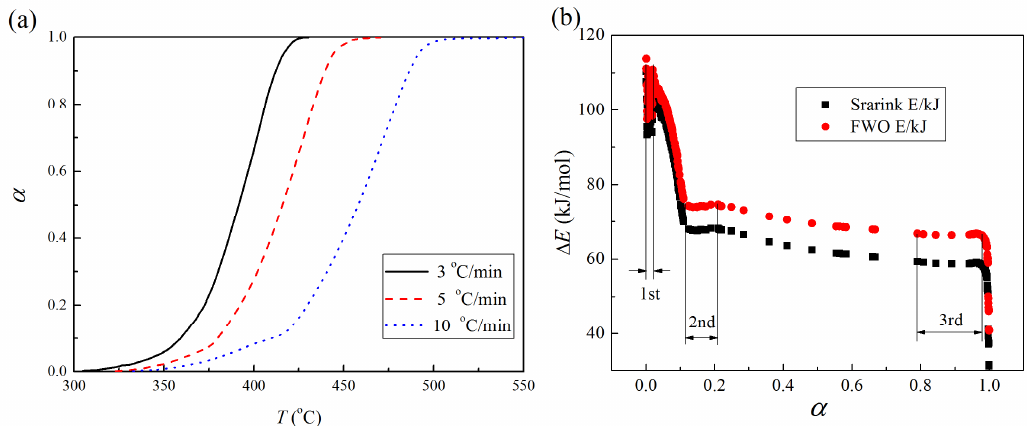
Figure 6. ( a ) Reaction fraction curves and ( b ) Activation energy of the reduction process of hematite particles without heat treatment in pure hydrogen. Table 1. Apparent activation energy of the three stages in the reduction process of hematite in hydrogen. E a (kJ/mol) 1st Stage 2nd Stage 3rd Stage